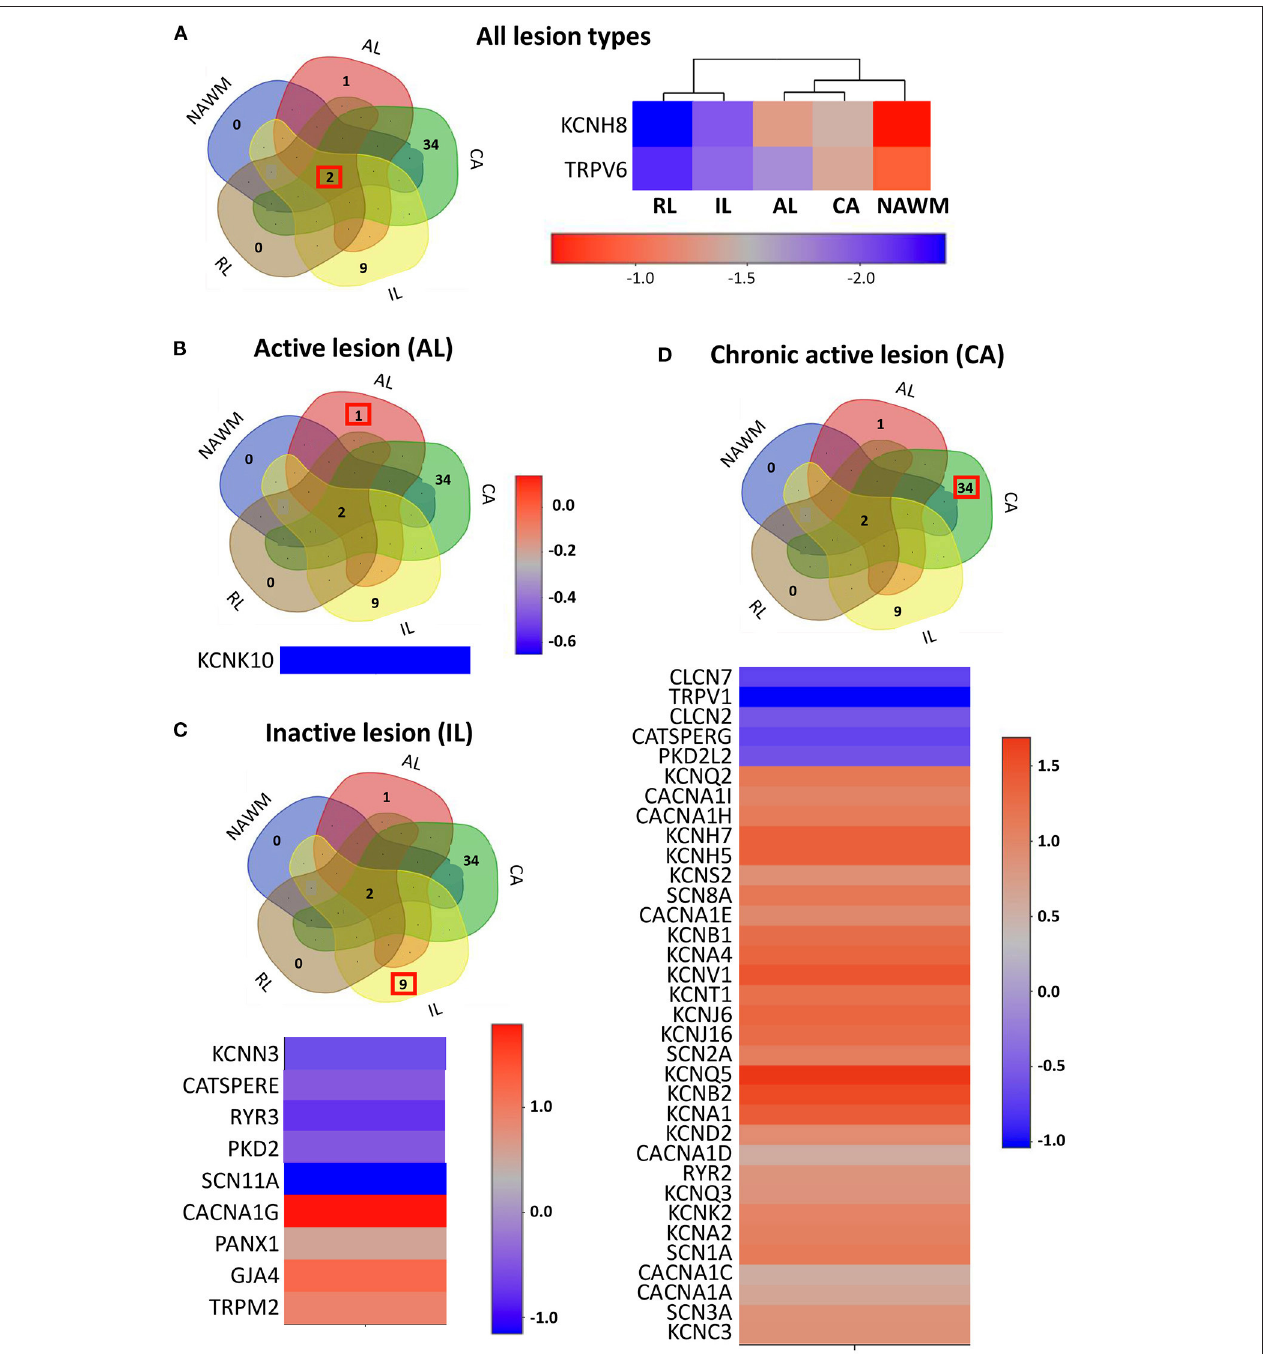
FIGURE 2 | The expression profile of the ion channel genes uniquely expressed in different lesion types. (A) Left panel: The Venn diagram represents the number of overlapping and lesion-specific differentially expressed genes coding for ion channels in chronic active (CA), active (AL), inactive (IL), and remyelinating (RL) lesions and in normal-appearing white matter (NAWM) compared to control white matter. Right panel: The heatmap shows two genes, coding for ion channels KCNH8 and TRPV6 that are significantly altered in all lesion types compared to control white matter. Scale bar indicates fold changes. (B) The Venn diagram, the heatmap, and the scale bar show the single ion channel gene, KCNK10, which is uniquely downregulated in active lesion (AL). (C) The Venn diagram, the heatmap, and the scale bar show the eight genes coding for ion channels that are uniquely significantly differentially dysregulated in inactive lesion (IL). (D) The Venn diagram, the heatmap, and the scale bar show the 33 genes coding for ion channels that are significantly and differentially dysregulated compared to control white matter in chronic active lesion (CA). The red box in Venn diagrams marks the genes that are specifically dysregulated in the corresponding type of lesion.